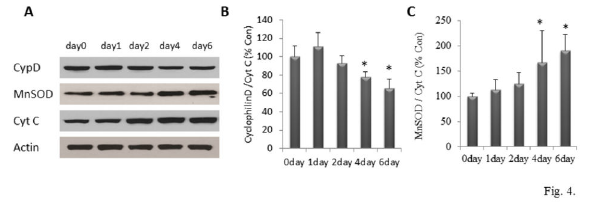
Figure 4. Expression of mitochondrial proteins in NPCs during differentiation. (A, B and C) Immunoblot analysis was performed by using antibodies that selectively recognize cytochrome c, MnSOD and cyclophylin D. Blots were reprobed with antibodies against Actin. Panel A shows representative blots; panels B and C show results of densitometric analysis of cyclophylin D and MnSOD, which were normalized to the corresponding mitochondrial cytochrome c level on each differentiation day. Values are expressed as a percentage of the mean of NPCs at day 0 (n = 3-4 separate experiments performed on cells cultured from 3-4 pregnant mice); *p<0.05 compared to the values of NPCs at day treatment of cells with 100 nM cyclosporine A (CsA), an inhibitor of the mPTP, increased mitochondrial membrane potential (Figure 5A) and reduced superoxide flash incidence (Figure 5C). Conversely, treatment of cells with 1 µM atractyloside (ATR), an agent that promotes opening of mPTPs, reduced mitochondrial membrane potential (Figure 5A) and increased superoxide flash incidence (Figure 5C). In addition, we found that mitochondrial superoxide generation and mitochondrial superoxide flash incidence were reduced in